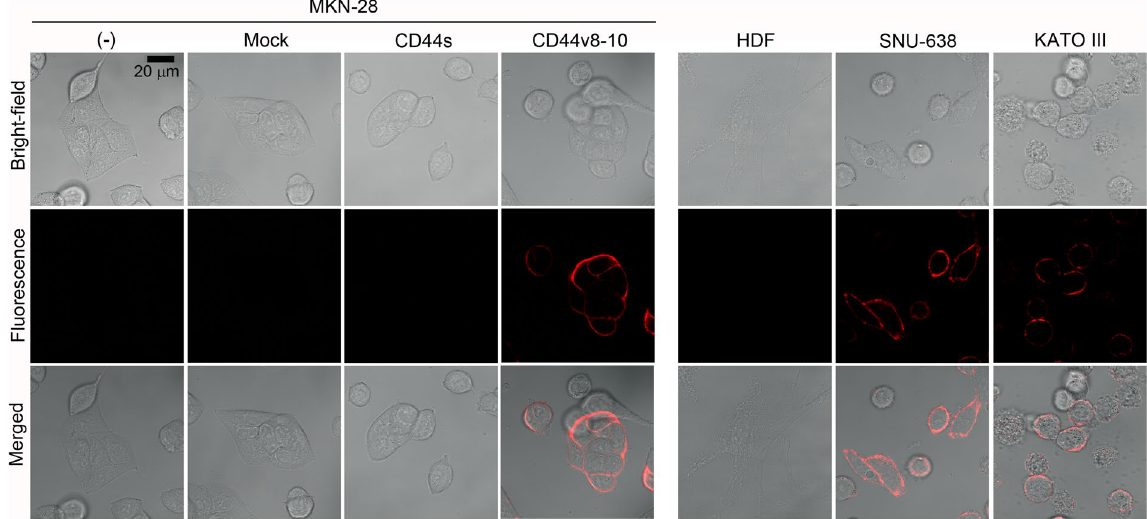
Figure 4. Specificity of ATTO680-conjugated anti-CD44v9 antibody on CD44v8-10( − ) or ( + ) cells confirmed by NIR fluorescence image. No fluorescent signal was detected in MKN-28 cells, mock vector transfected MKN- 28 cells, CD44s transfected MKN-28 cells, and HDF cells. The CD44v8-10 expressing MKN-28 cells, SNU-638 and KATOIII cells, clearly showed fluorescence on the lining of the cell membrane. Scale bar indicates 20 μ m.